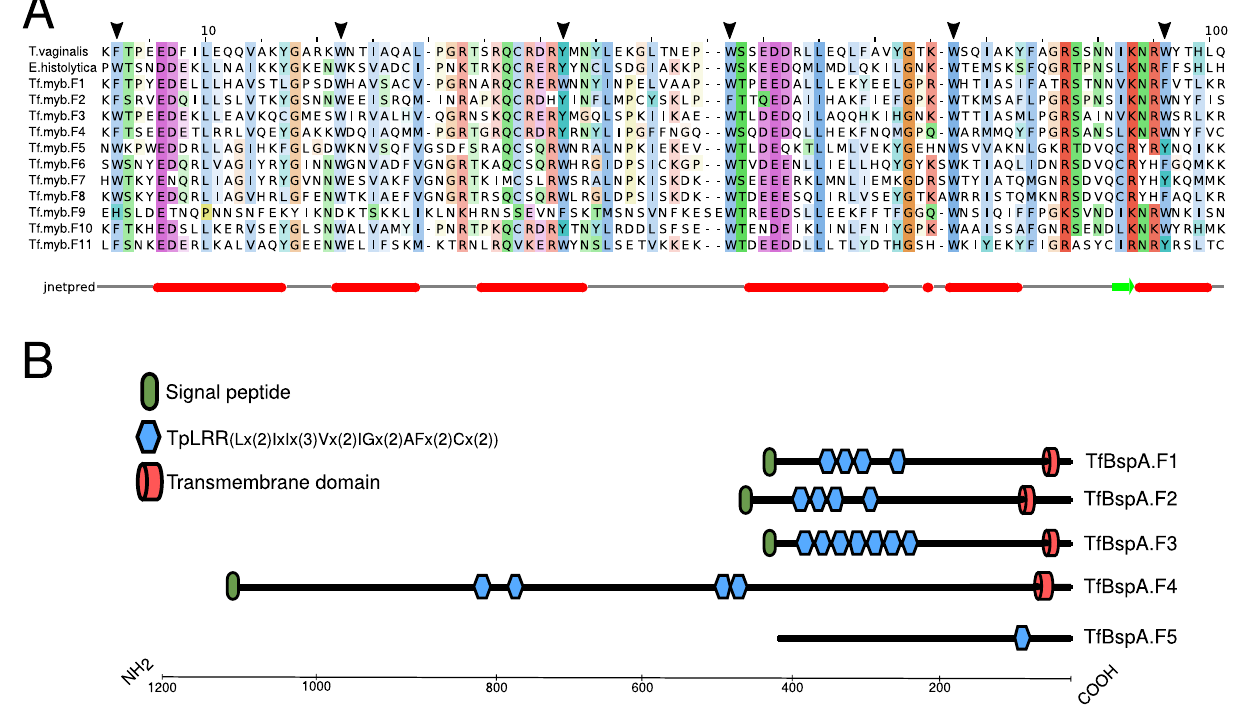
Figure 2. Specific abundant transcripts in G10/1 isolate are related to Myb-like and BspA-like proteins. ( A ) A multiple sequence alignment of predicted amino acid sequences for G10/1 MYB transcripts and E. histolytica (XP_648148.1) and T. vaginalis (XP_001307180.1); these are MYB validated proteins. Black arrowheads highlight conserved tryptophan (W) residues characteristic from the MYB family. At bottom, a schematic representation of second structure prediction by JPred algorithm, JNetPRED refers to the consensus prediction 34 . Red bars represent alpha helix and sheets are presented as green arrows; ( B ) Schematic description of predicted amino acid sequences for G10/1 isolate transcripts related to BspA-like proteins. TpLRR: Treponema pallidum leucine rich repeat 66